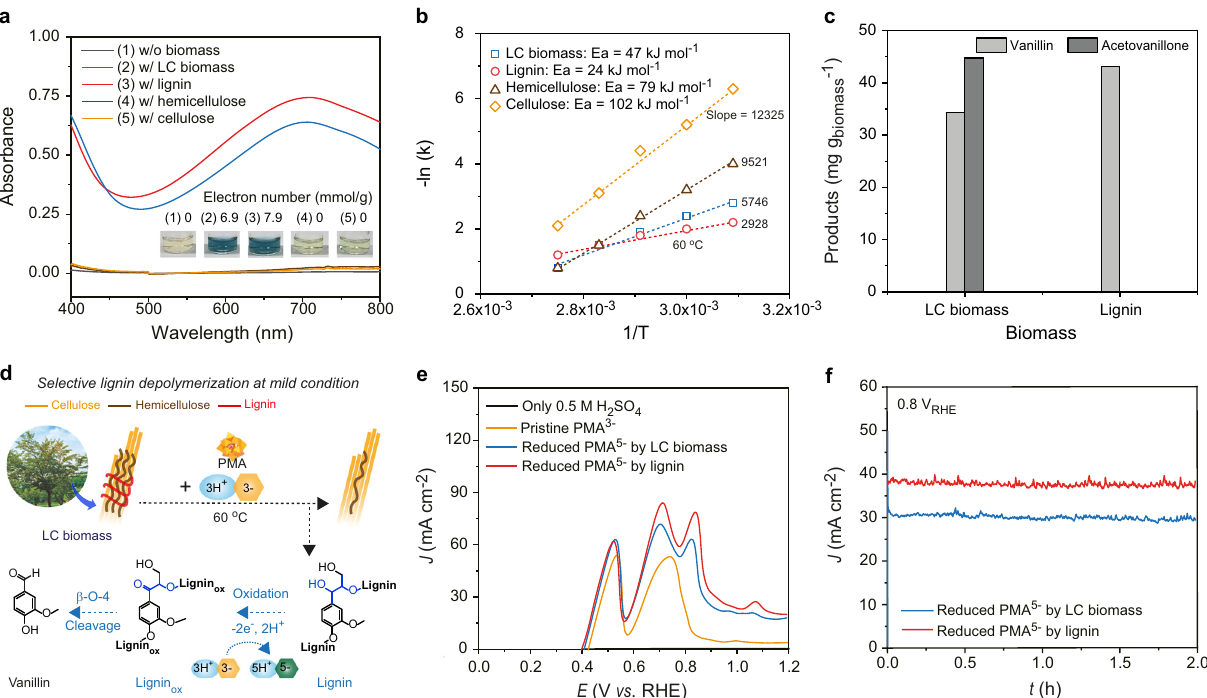
d Schematic illustration of electron extraction and production of value-added chemicalsfromLCbiomassviatheselectivedepolymerization. e LSVcurvesofonly lignin. f CA curves of reduced PMA 5 − by LC biomass and lignin at 0.8V vs.